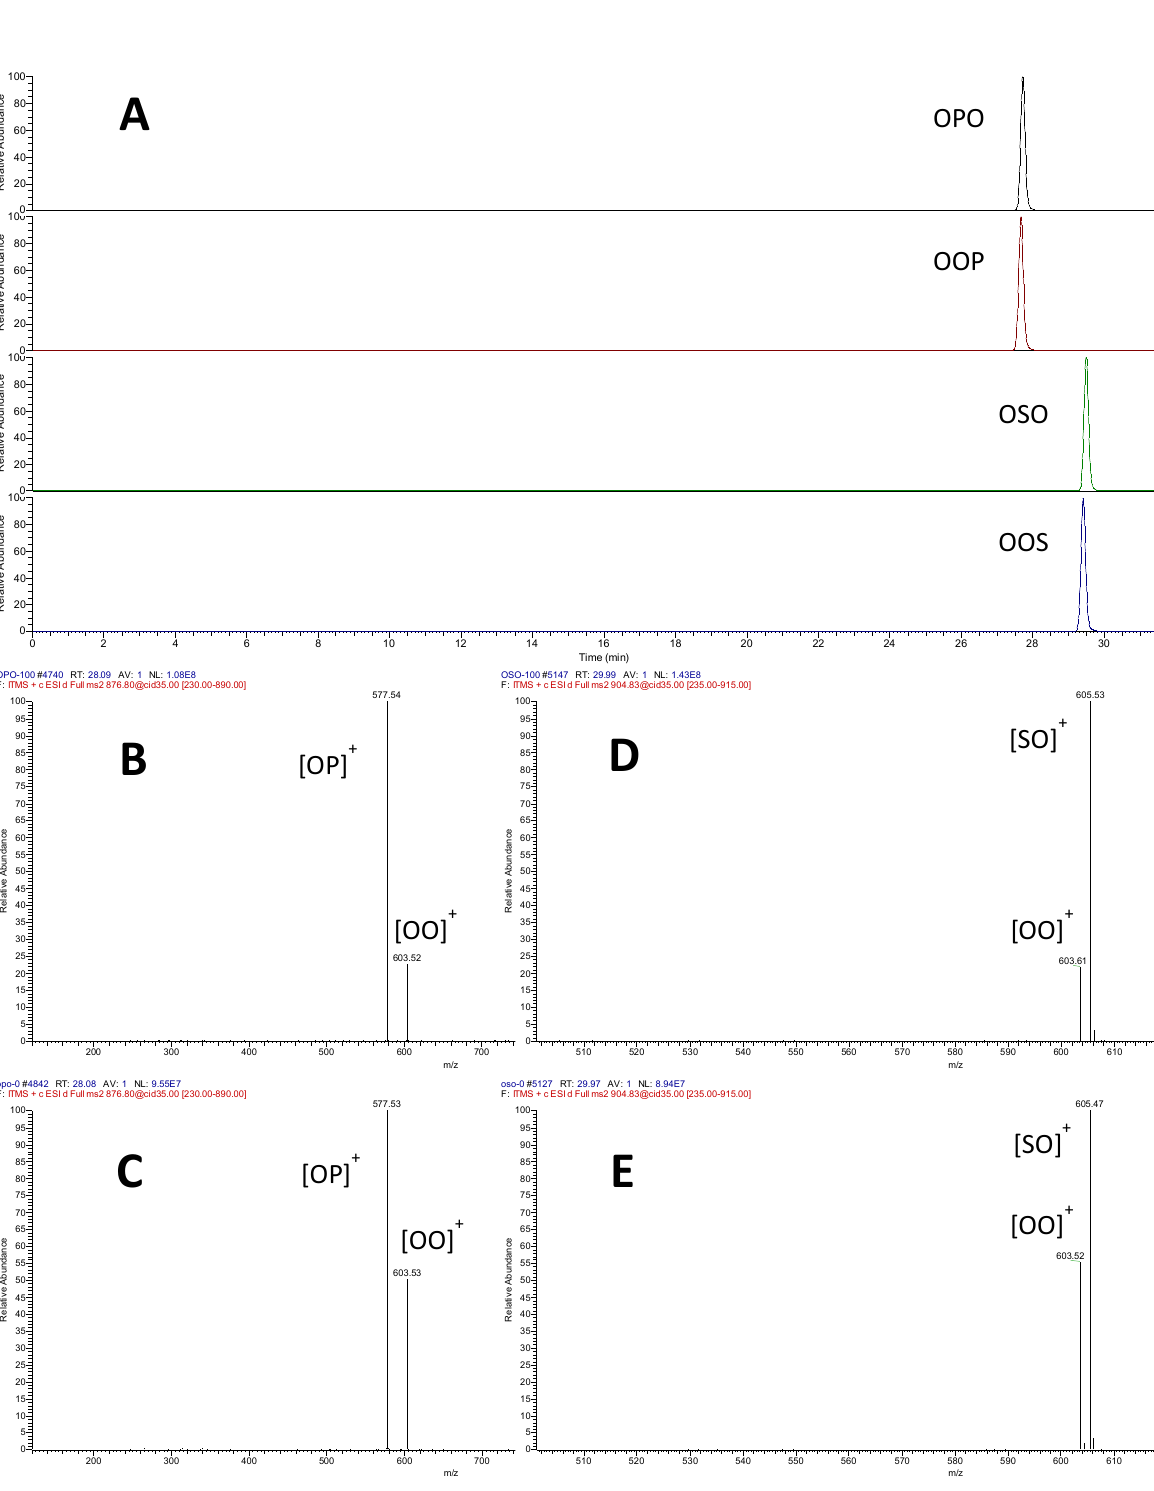
Figure 1. Extracted ion chromatogram (EIC) profile of OPO, OOP, OSO, and OOS standards ( A ) and their respective MS2 spectrum (( B ) OPO; ( C ) OOP; ( D ) OSO; ( E ) OOS). P: palmitic acid; O: oleic acid; S: stearic acid. [OP] + , [OO] + , and [SO] + are fragment ions or DAG +